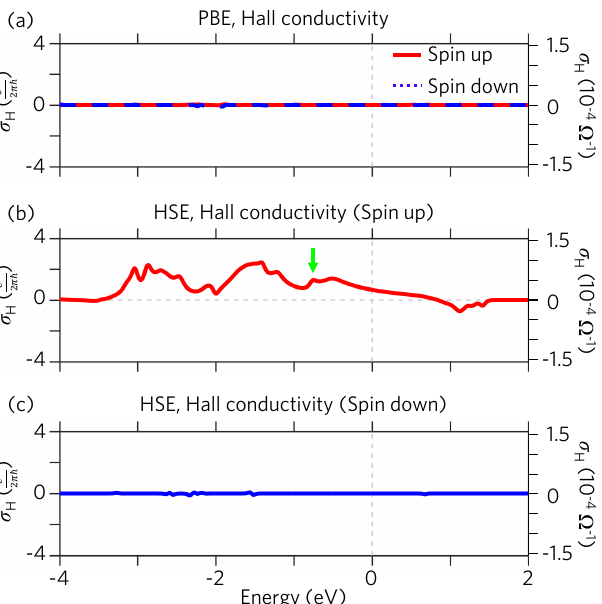
Figure 4. The intrinsic Hall conductivity from DFT simulations with temperature T = 200 K . ( a ) The Hall conductivity of spin up and down electrons from PBE simulations. The left (right) axis show the Hall conductivity in the unit e 2 (10 − 4 Ω − 1 ). ( b , c ) The Hall conductivity of spin up and 2 π ¯ h down electrons from HSE simulations. The green arrow highlights the peak enhanced by the band crossing